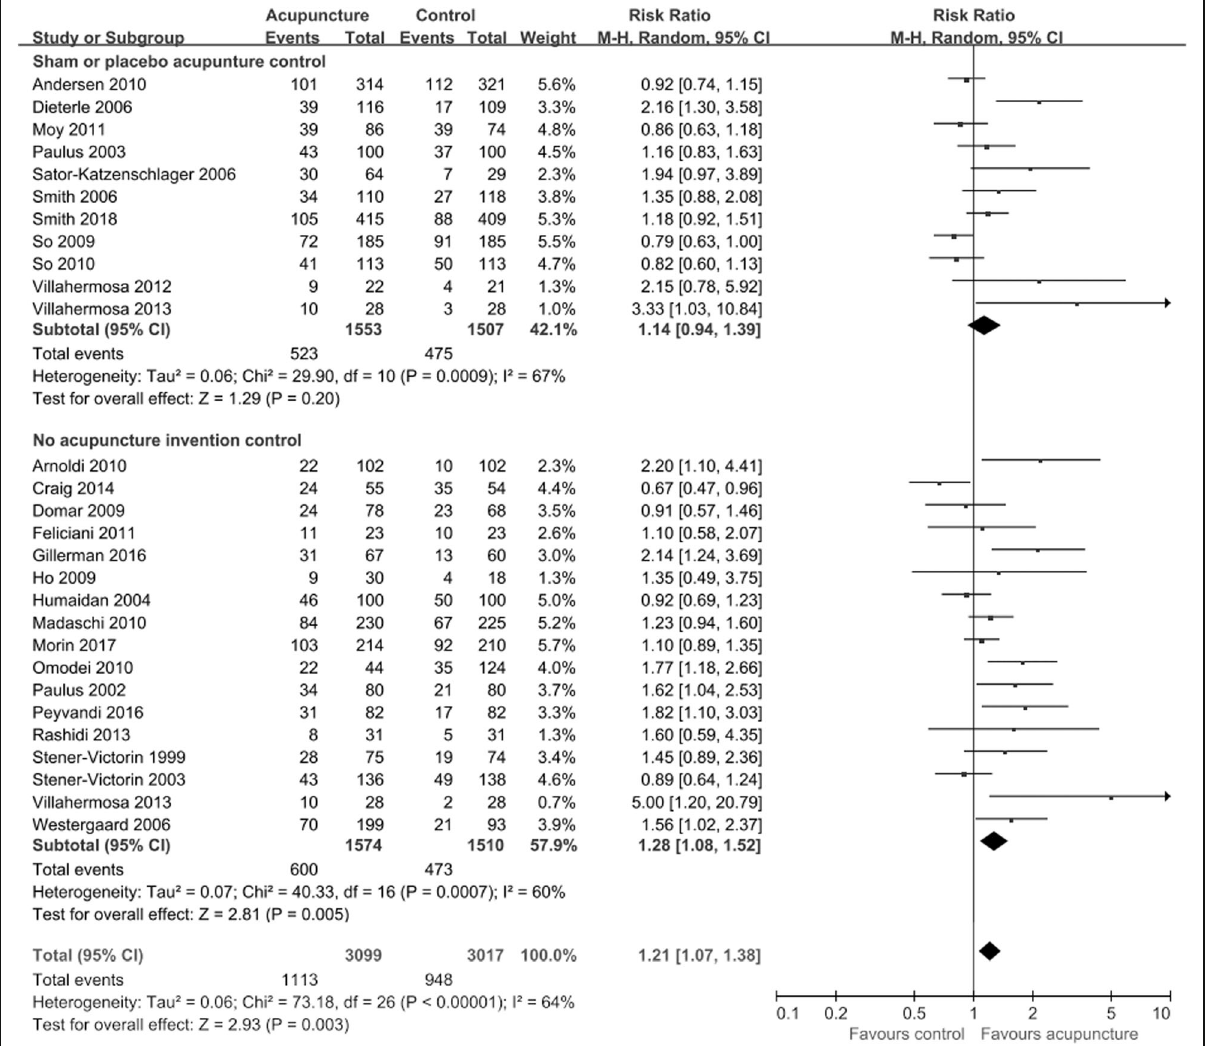
Fig. 2 Effect of acupuncture on the clinical pregnancy rates in women undergoing IVF. Villahermosa 2013 had one acupuncture group and two control groups (sham acupuncture group and no intervention control group), two control groups were grouped separately for relevant subgroup analysis, and when calculated the total pooled risk ratio (RR), we took them